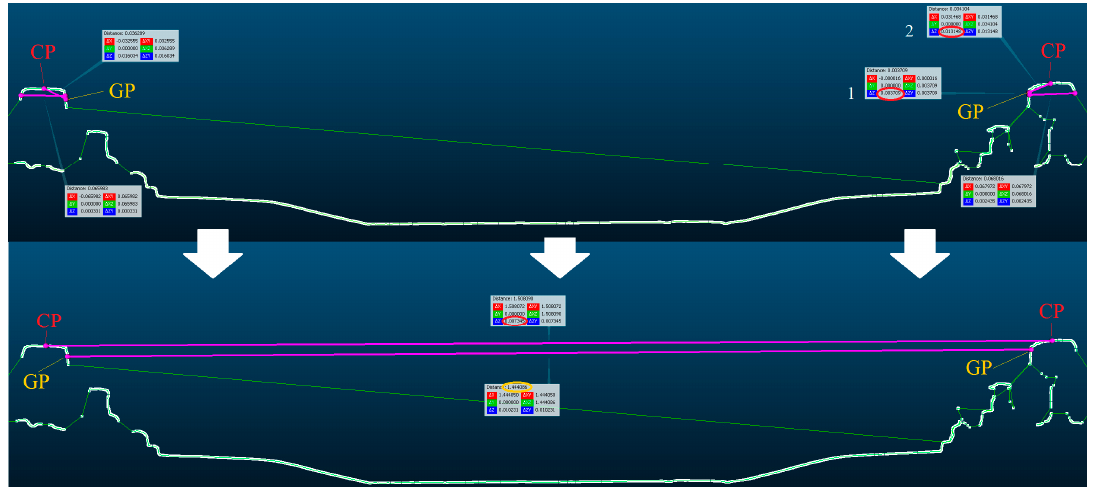
Figure 4. Cant point (CP) and gauge point (GP) definition and measurement of the track gauge and cant in CloudCompare application.